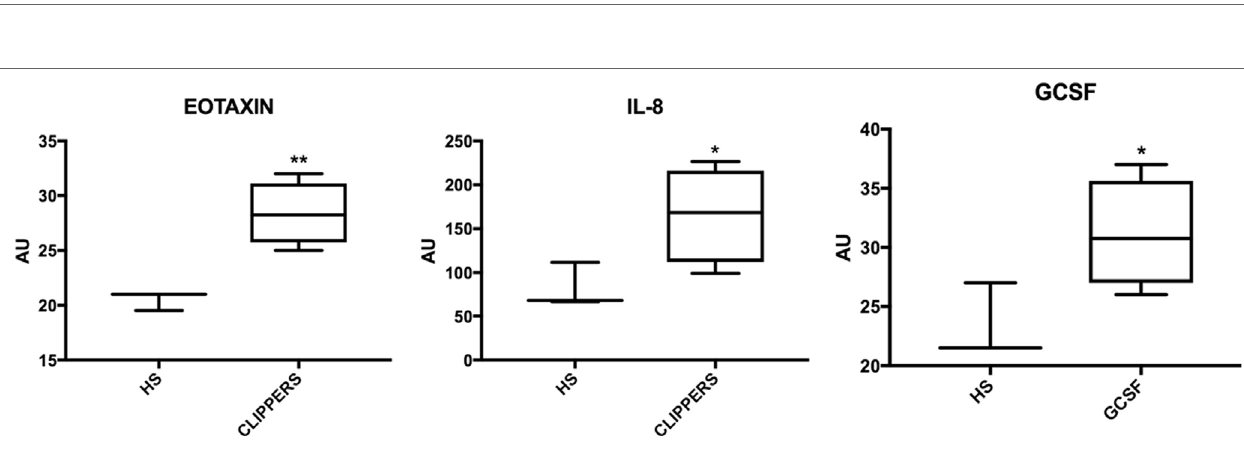
FigUre 4 | Vascular pathology in chronic lymphocytic inflammation with pontine perivascular enhancement responsive to steroids. Immunohistochemical analysis of brain samples of the autopsy case (patient #5). (a) Damage of the vessel wall is indicated by staining with hematoxylin–eosin. (B) Glia limitans is preserved (GFAP staining). (c) Partial loss of CD31 (PECAM) reactivity from endothelia of affected vessels indicates damage of endothelial cells. (D) Reactivity with smooth muscle actin (SMA) staining is lost in the walls of inflamed vessels. (e) This vessel pathology is associated with immunoglobulin (IgG) reactivity. (F–h) Complement activation (C3bc, C3d, and C9neo) is accentuated in the vessel wall. (i) IgG reactivity and complement activation partially overlap. Magnification bars represent 100 μ